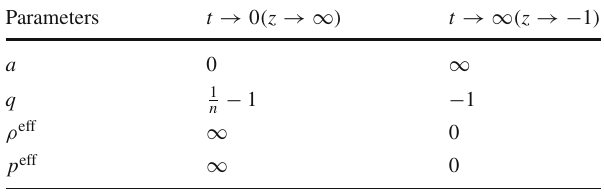
Table 1 Asymptotic behavior of the cosmological parameters Parameters